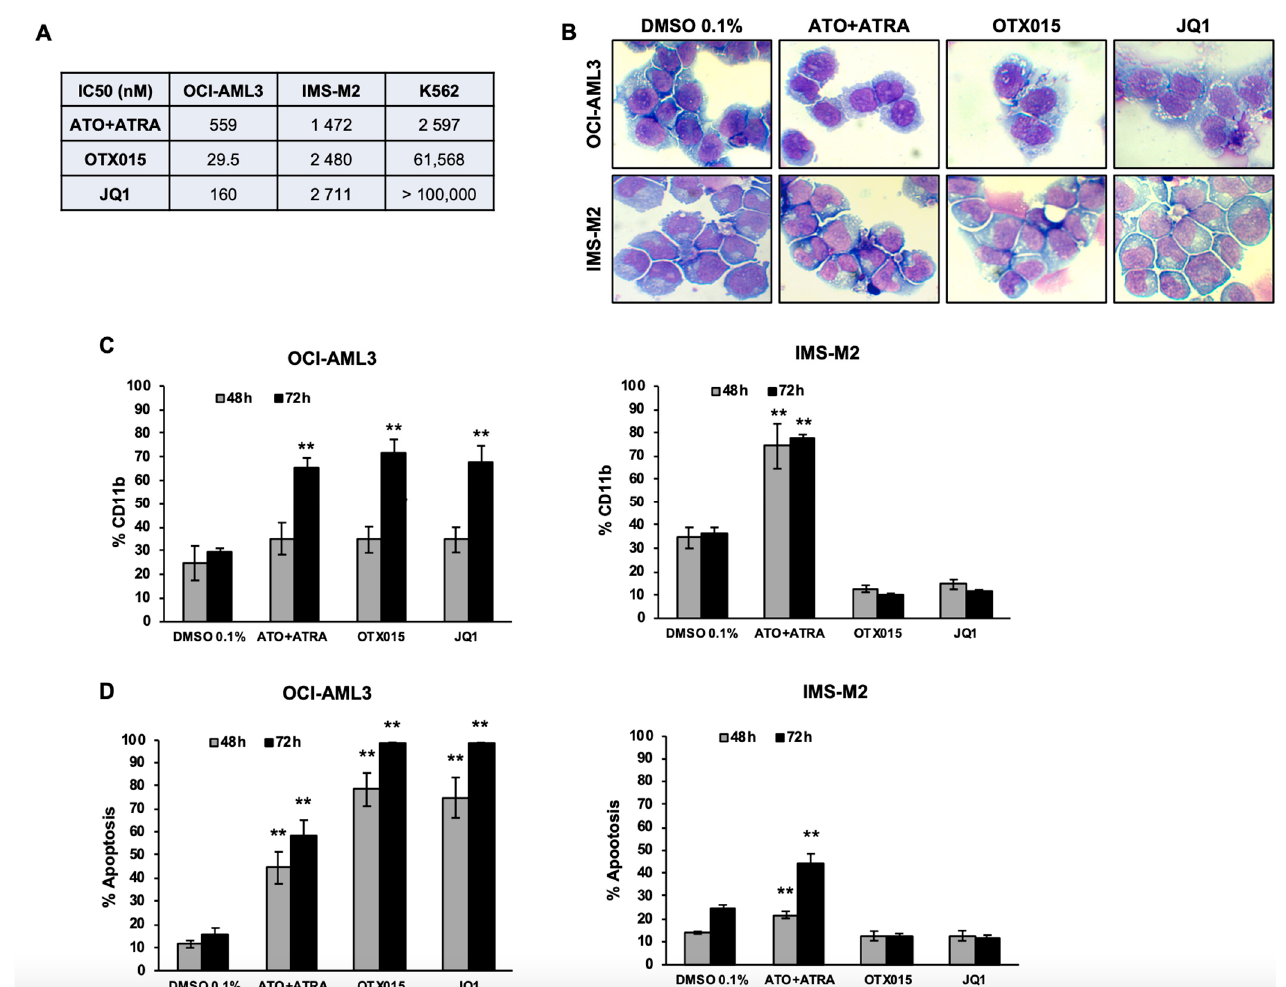
Figure 1. IC50, differentiation and apoptosis induced by BETi compared to ATO + ATRA in NPM1c and K562 cell lines. ( A ) OCI-AML3, IMS-M2, and K562 were exposed for 72 h to increasing doses of indicated drugs, and ApoTox-Glo TM assays were performed to determine IC50 of the indicated cell lines. ( B ) Cell morphology of OCI-AML3 and IMS-M2 after treatment either with 0.1% DMSO, 1000 nM ATO + 1000 nM ATRA, 500 nM OTX015 (MK-8628), or 500 nM JQ1 was studied at 48 h by May-Grünwald-Giemsa staining after cytospin. ( C ) The expression of the differentiation marker CD11b was detected by flowcytometry using a human CD11b-specific mouse monoclonal antibody on OCI-AML3 and IMS-M2 cells treated for 48–72 h either with 0.1% DMSO, 1000 nM ATO + 1000 nM ATRA, 500 nM OTX015 (MK-8628), or 500 nM JQ1. ( D ) OCI-AML3 or IMS-M2 cells were exposed 48–72 h either to 0.1% DMSO, 1000 nM ATO + 1000 nM ATRA, 500 nM OTX015 (MK-8628), or 500 nM JQ1. Apoptosis was detected with annexin V and PI by using flow cytometry. Apoptotic cells were defined as annexin V + with or without PI uptake. Results are shown as mean ± SEM from duplicates of three independent experiments. ** represents p ≤ 0.01.